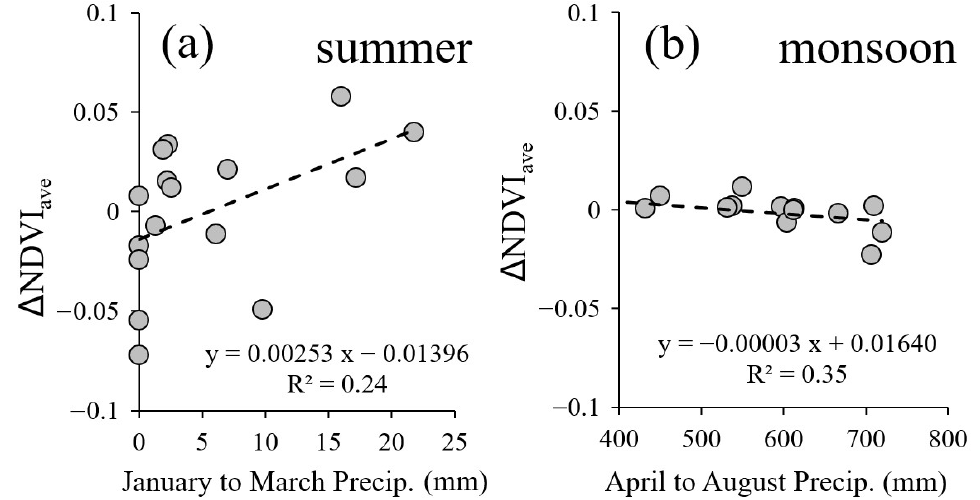
Figure 12. The comparison between precipitation and NDVI difference for ( a ) summer and ( b ) monsoon cultivation seasons.